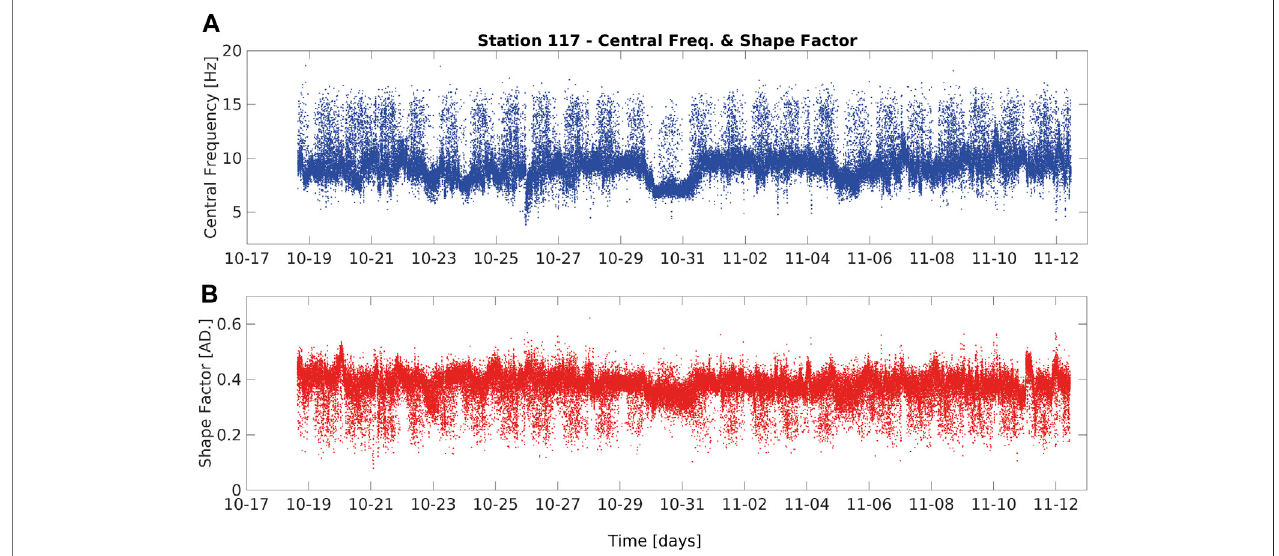
FIGURE 3 | Spectral parametrization of the dataset recorded from 19 October to 13 November 2018 at node 117, in terms of central frequency (top) and shape factor (bottom).